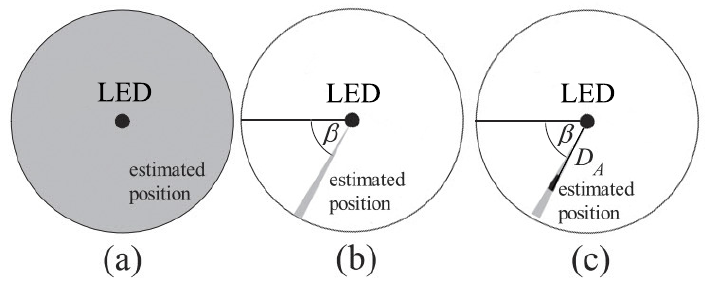
Figure 3. Estimated position by ( a ) VLID; ( b ) VLID and azimuth angle; and ( c ) VLID, azimuth, and tilt